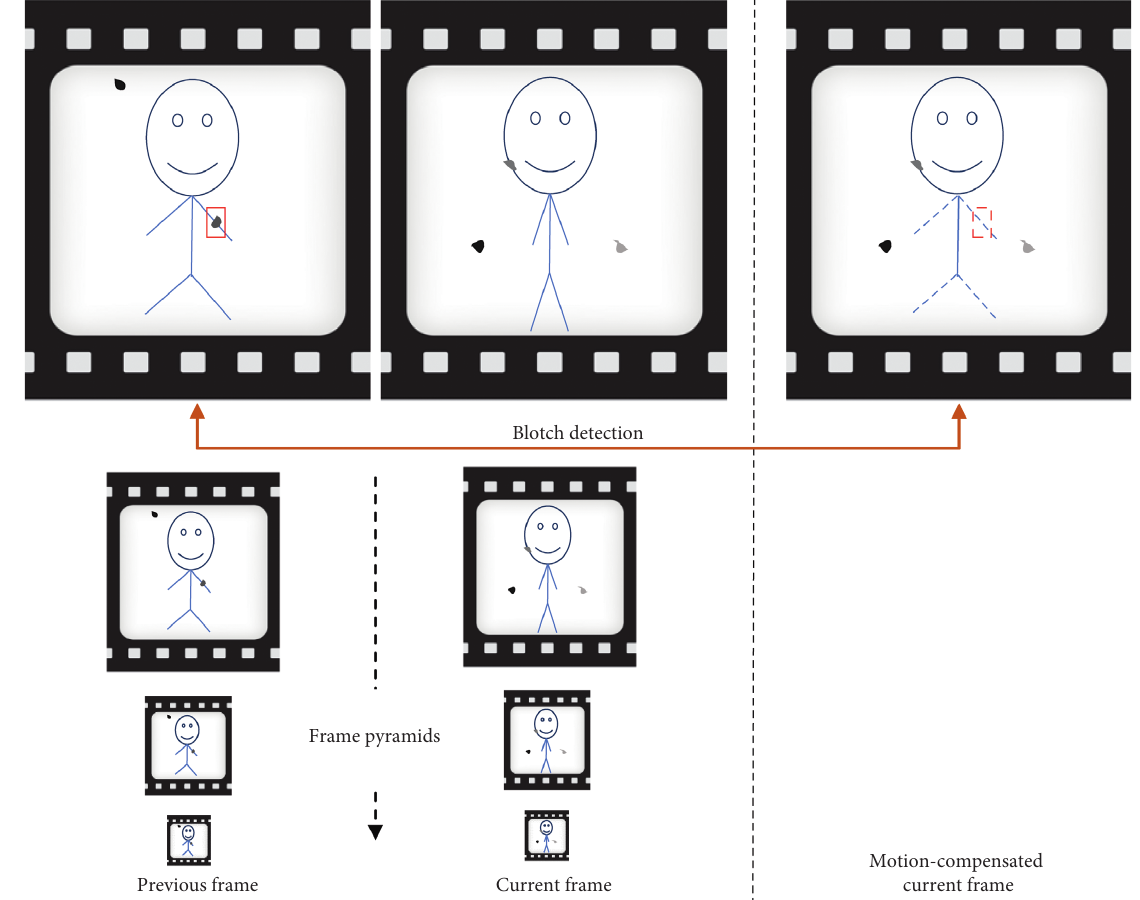
Figure 2: Motion estimation and compensation procedures for the blotch detection phase [9]. Here, a hierarchical approach is used for shrinking blotch regions and estimating large